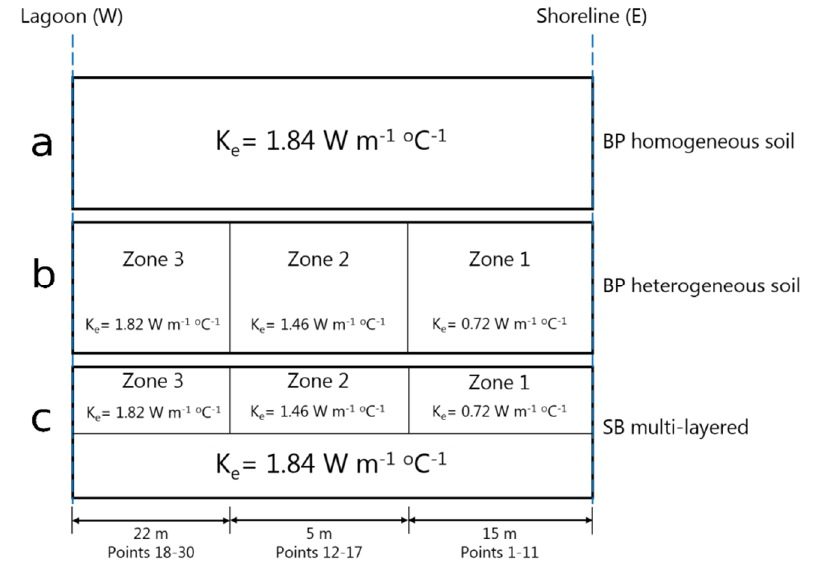
Figure 2. A schematic cross section of the study area with different zonation and parametrization for the lagoon bed temperature analysis. ( a ) BP homogeneous soils scenario with a single thermal conductivity, ( b ) BP heterogeneous soil scenario. Three zones are defined, each of them with a different thermal conductivity, ( c ) SB multi-layered. See text for the definition of the two BP and SB analytical solutions. Three different zones and two layers per zone are defined. Each zone has a different thermal conductivity for the upper layer. All zones have the same thermal conductivity for the lower layer.